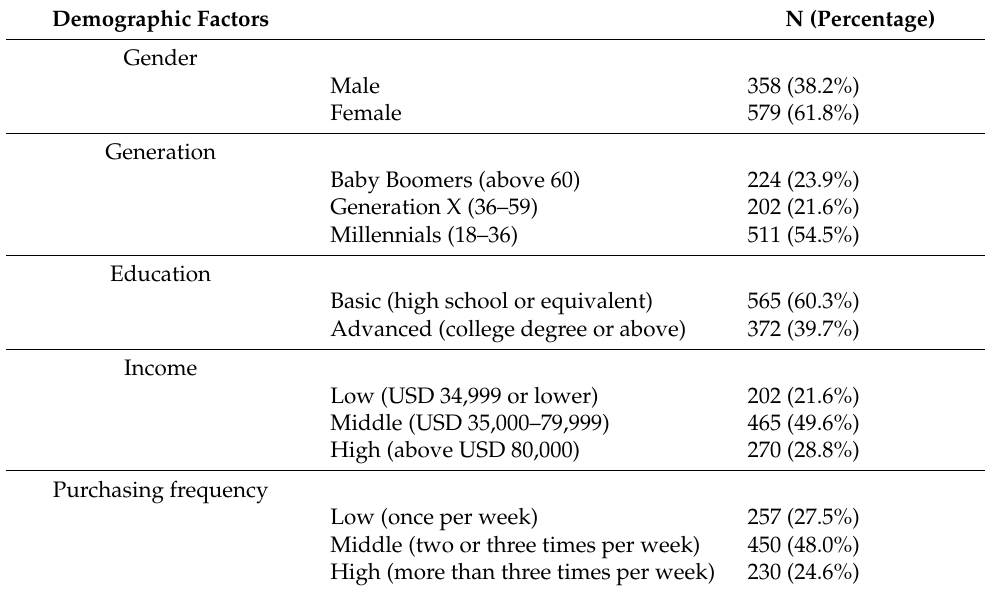
Table 1. Descriptive analysis of demographics of respondents (N = 937).